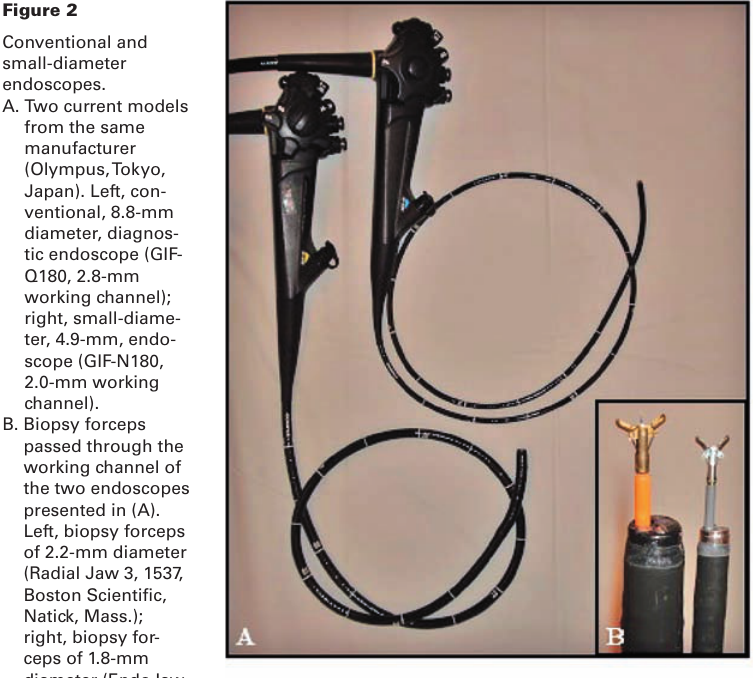
Conventional and small-diameter endoscopes. A. Two current